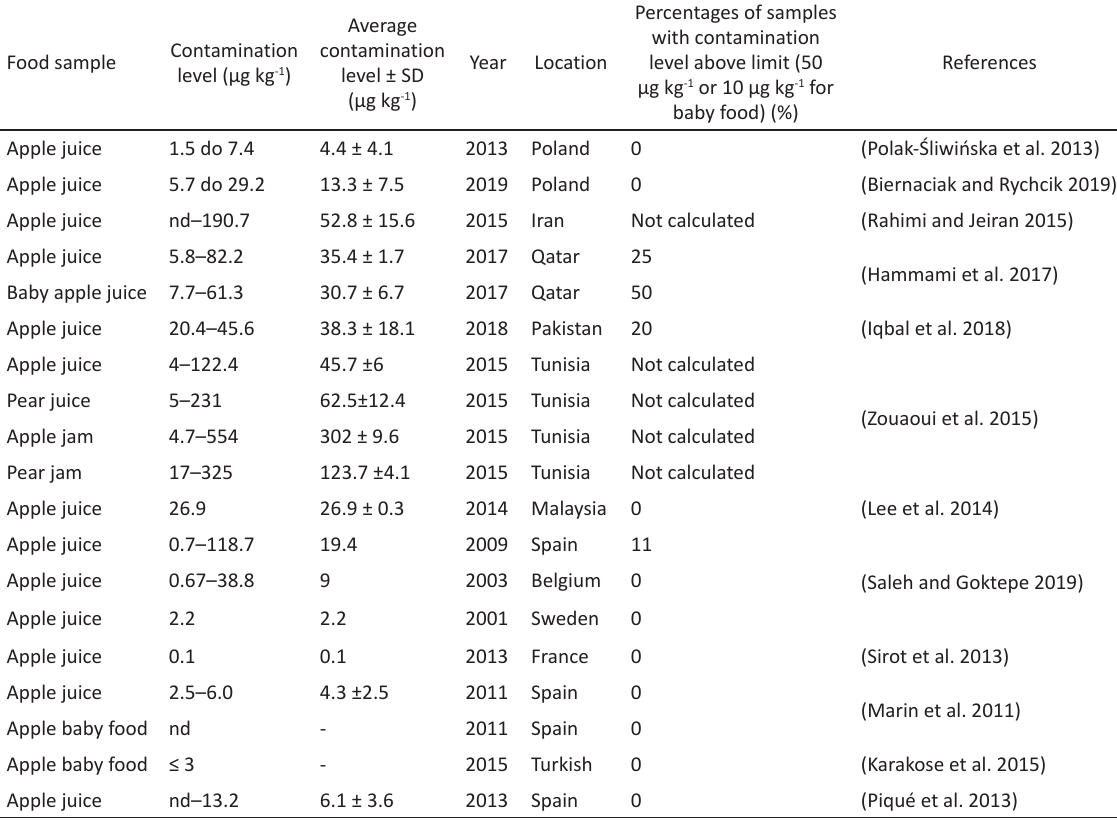
Table 5 . The concentration of patulin in various food products